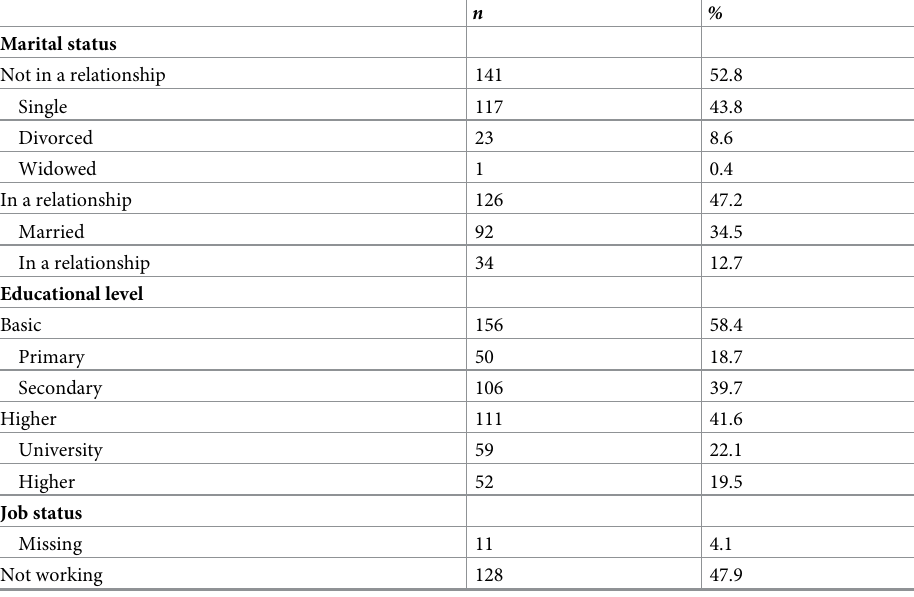
Table 1. Sample characteristics ( N =